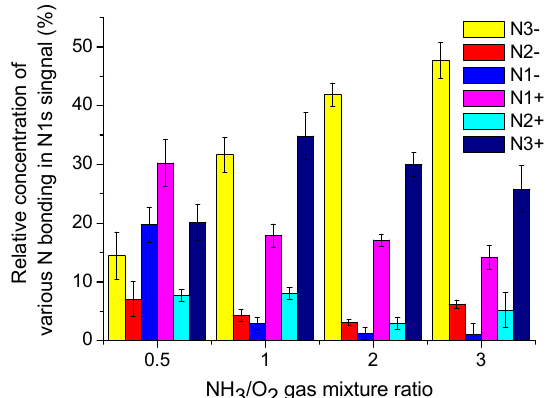
− , N 2 − , N 1 − , N 1 + , N 2 + , and N 3 + species as functions of the NH